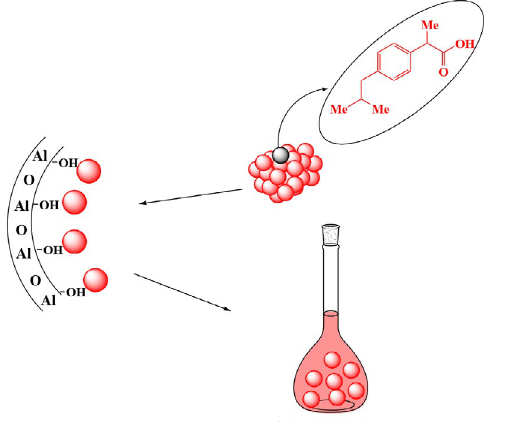
Fig.1. Preparation of the nano drug